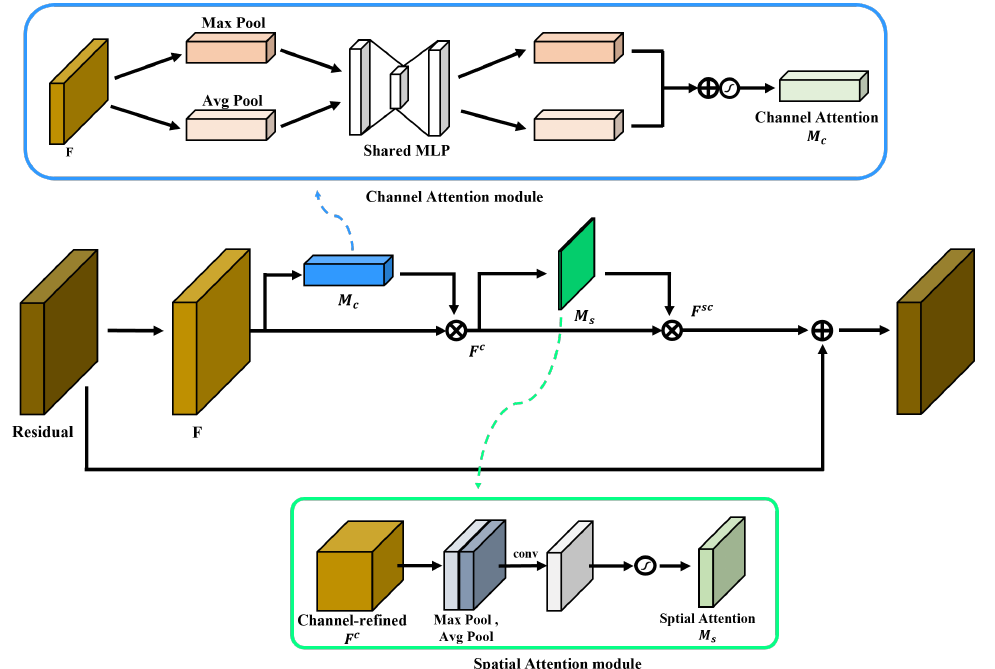
Figure 4. Convolutional block attention module (CBAM) architecture in residual